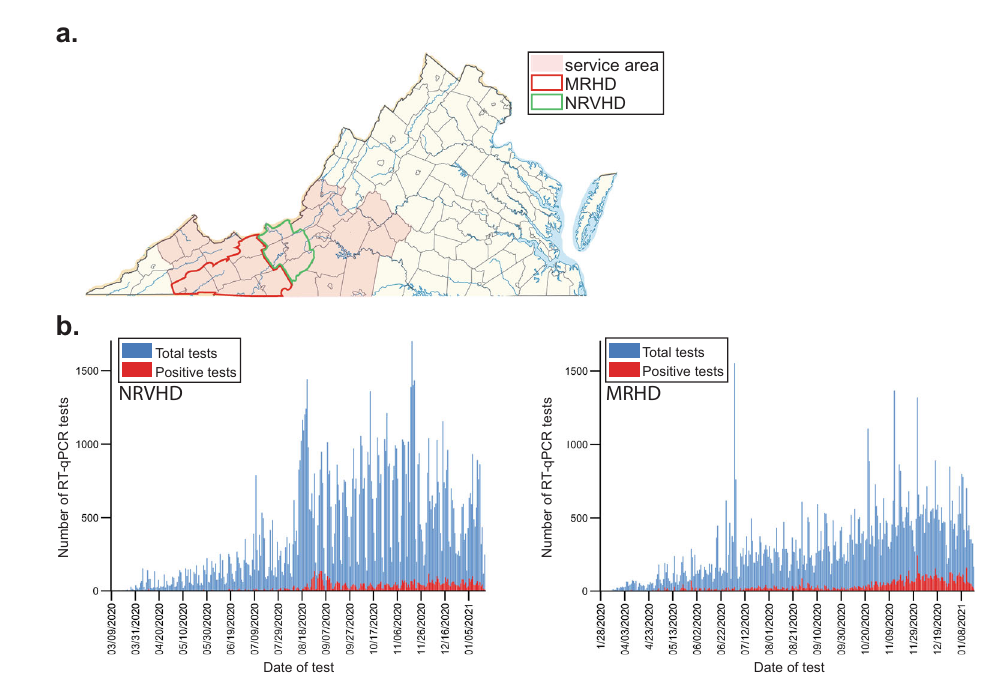
Fig. 2 Testing implementation in rural Virginia. a Map of the State of Virginia, U.S. with all 95 counties and 38 independent cities, considered county- equivalents, on display. Our laboratory ’ s service area is shaded in orange. The limits of the New River Valley Health District (NRVHD) and Mt. Rogers Health Districts (MRHD) are indicated in green and red, respectively. b Graphs indicate the daily number of RT-qPCR tests processed (blue) in NRVDH (left) and MRHD (right) along with the number of positive results